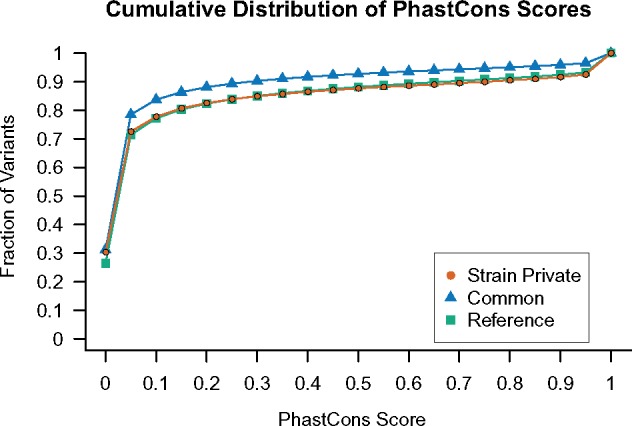
The cumulative distribution of PhastCons conservation scores for strain private and common variants, as well as all sites on the C57BL/6J reference sequence. Common variants are defined as those with the alternative allele present in two or more classical laboratory strains. Only nonrepeat masked sites are considered. The 95% bootstrap confidence intervals associated with each point are narrower than the plotting characters and are therefore omitted from the figure.